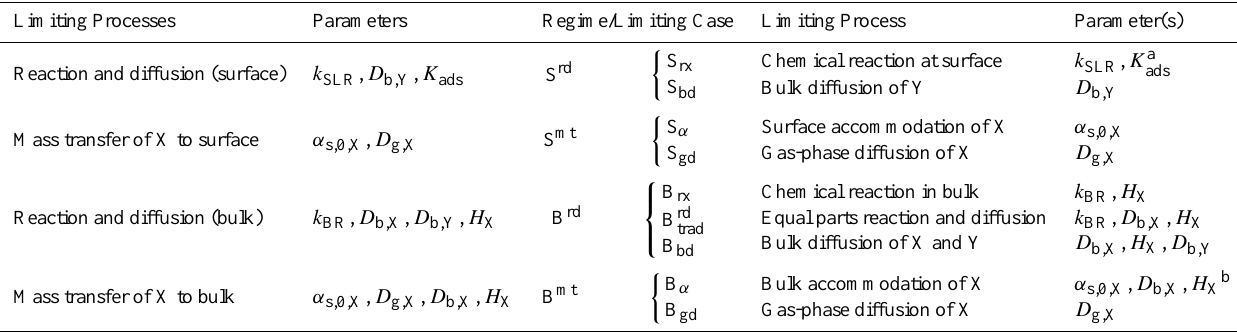
Table 3. List of kinetic regimes and limiting cases and their respective controlling processes. Limiting cases are characterised by being controlled by one process, while systems in the regimes shown here are controlled by at most two processes. The parameters which influence the processes are given in a separate column and are defined in Table 2.